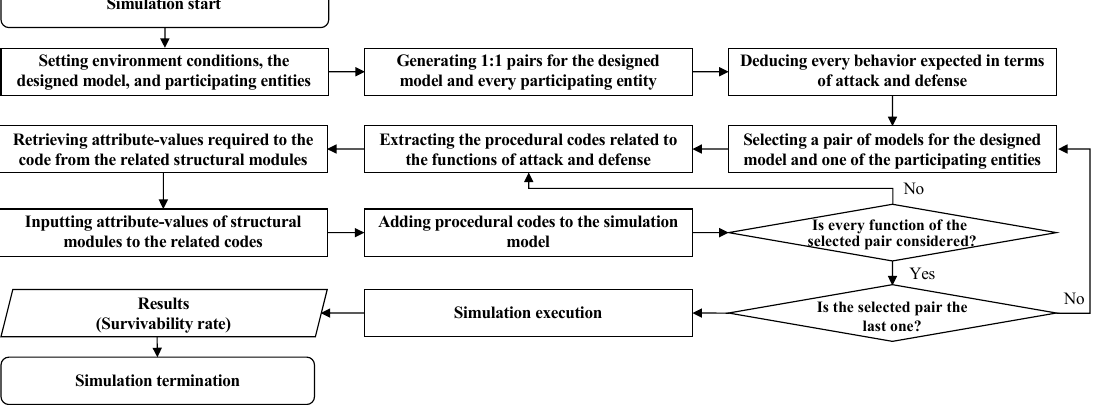
Figure 5. Interactive simulation process.